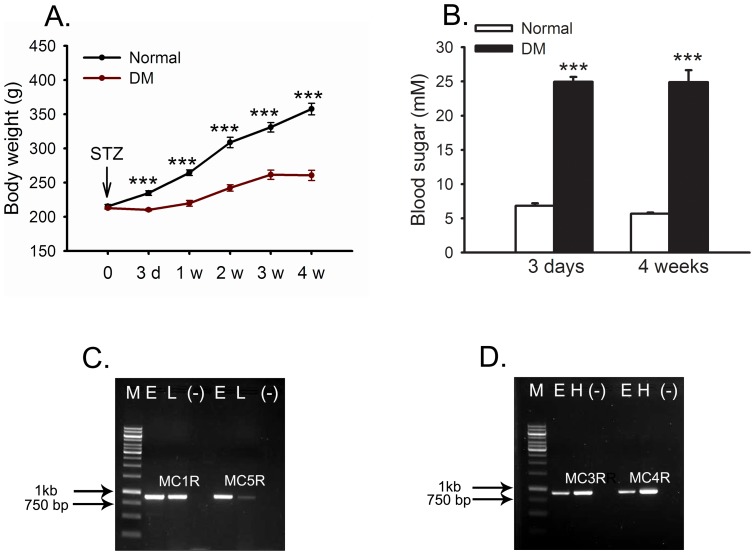
Body weight, blood glucose and MCR expression in STZ-induced diabetic rats.The body weight of the diabetic rats was significantly lower than that of the normal counterparts (A). The blood glucose levels of the diabetic rats averaged at 25 mM at both 3 d and 4 w after diabetic induction and were significantly higher than the normal rats (B). The expression of MC1R and MC5R (C), MC3R and MC4R (D) were detected with the expected size by regular RT-PCR. M: 1 kb DNA ladder, two arrows designate the position of 750 bp and 1 kb fragment in the ladder. E: retina from the eye; L: liver; H: hypothalamus; (-): negative control. *** p<0.001.